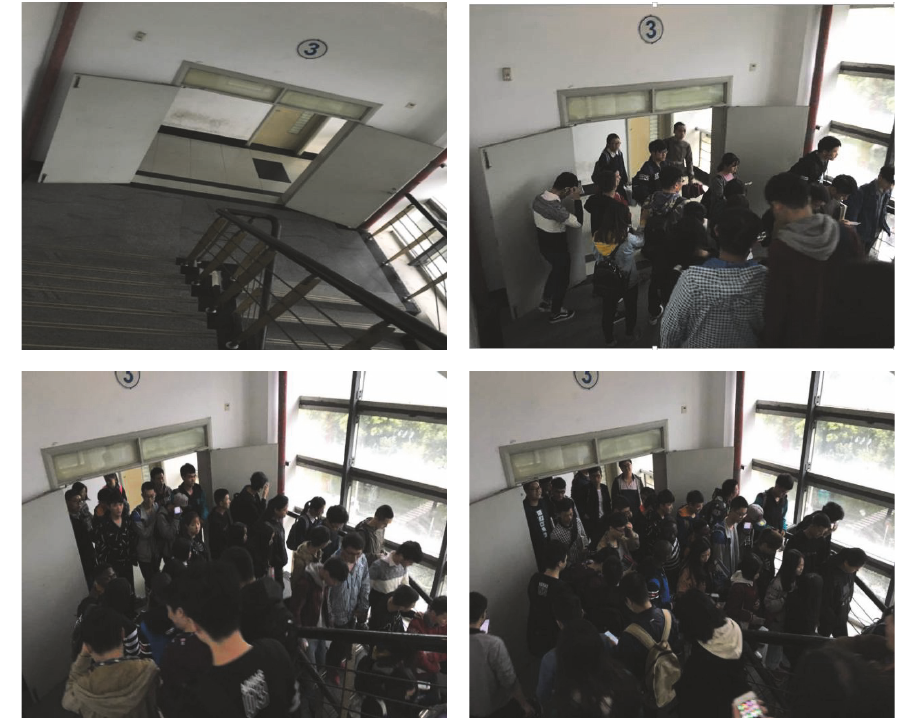
Figure 5: The practical evacuation scene in different time for the merging form of type3.